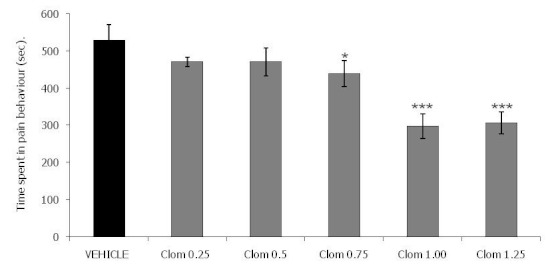
Clomipramine late phase of formalin test. Each group represents the mean ± SEM of 10 animals. *p<0.05, ***p<0.001 when compared with the control value subsequent to ANOVA